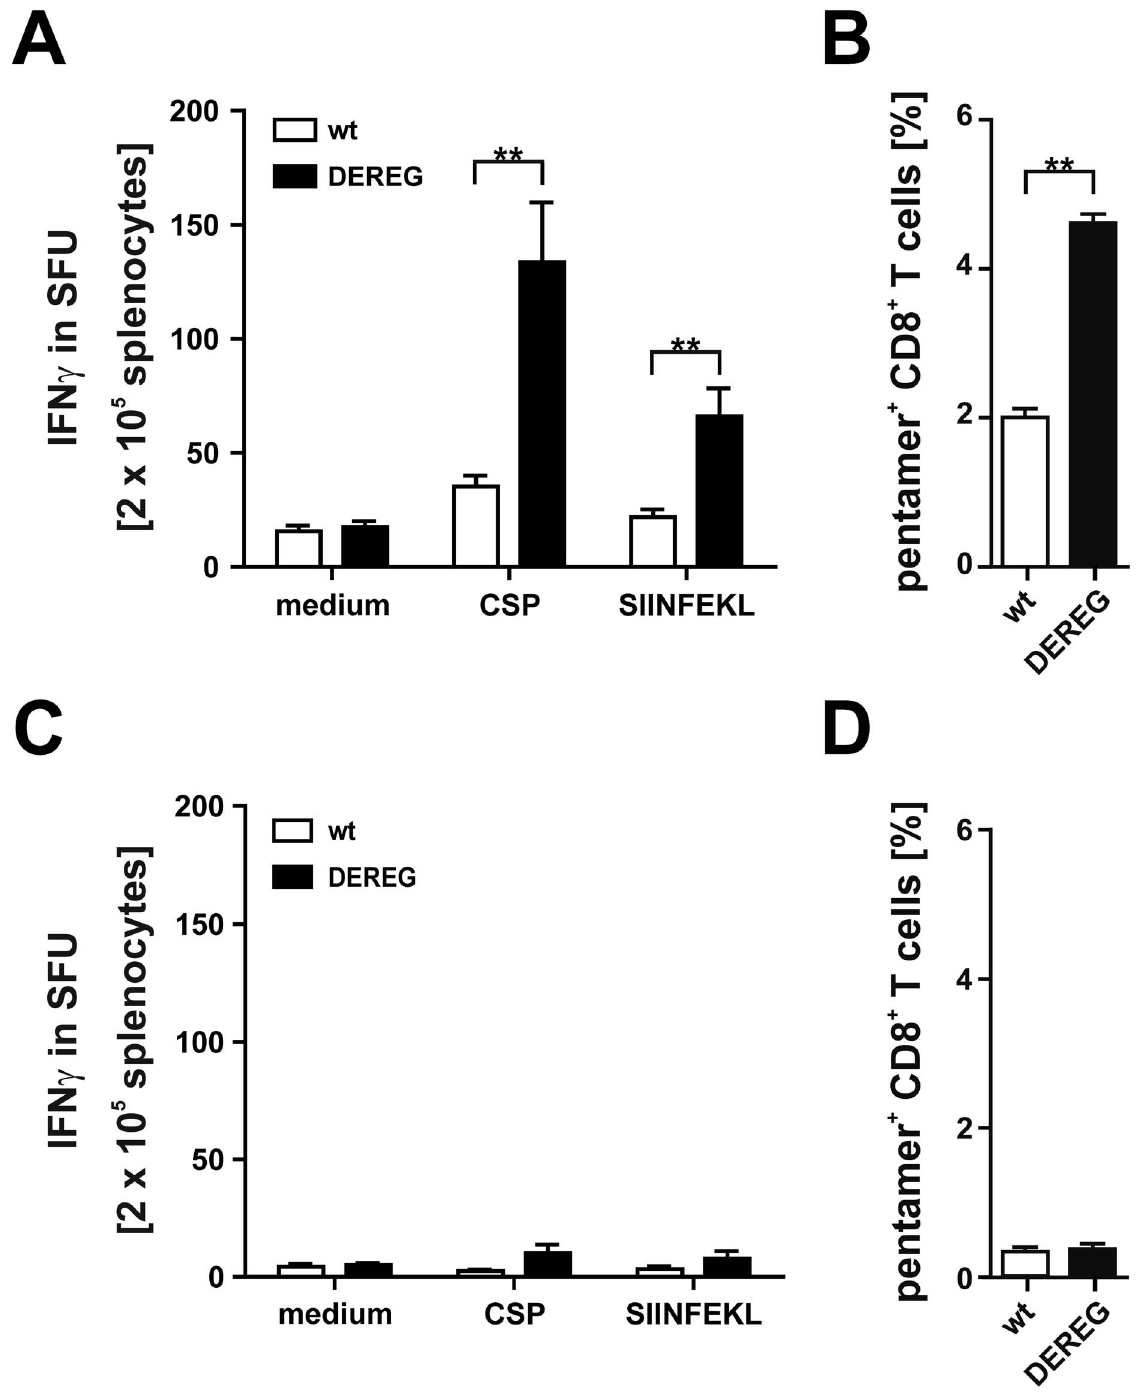
Figure 3. Effect of T reg depletion on the efficacy of a primary immunization. (A) To analyze the effect of T reg depletion on the efficacy of immunization, we immunized the F1 generation from male DEREG-mice on C57BL/6 background and female wildtype BALB/c mice (F1 DEREG) on day 0 using i.p. application of 20 m g of an adenylate cyclase toxoid (ACT-CSP) that carries an insert of the P. berghei CSP-derived CD8 + T cell epitope SYIPSAEKI presented on H-2K d (corresponding to residues 245 to 253 from CSP) and the OVA-derived SIINFEKL epitope, presented in the context of H-2K b (corresponding to residues 257 to 264 from OVA). On day + 1, + 2, and + 3 immunized F1 DEREG and F1 non-transgenic littermates were treated with DT. On day + 7, spleen cells were restimulated with CSP-peptide or OVA-peptide and IFN c production in spot forming units (SFU) was analyzed using ELISPOT. Data are expressed as mean + / 2 SD of 5 mice. This experiment was repeated twice with similar results. (B) Percentage of CD8 + CSP + spleen cells stained using PE-labeled anti-CD8 and APC-labeled MHC-I-pentamer loaded with CSP-peptide to detect CSP-specific CD8 + T cells. The mean of five immunized F1 DEREG mouse or a F1 non-transgenic littermates is shown. The percentage of CD8 + CSP + T cells is expressed as mean + / 2 SD of whole lymphocytes. (C) A similar experiment was performed using again F1 DEREG mice and F1 non-transgenic littermates that were treated on days + 1, + 2, and + 3 with DT but without previous immunization. Data are expressed as mean + / 2 SD of 5 mice. This experiment was repeated once with similar results. (D) Percentage of CD8 + CSP + spleen cells stained using PE-labeled anti-CD8 and APC-labeled MHC-I-pentamer loaded with CSP-